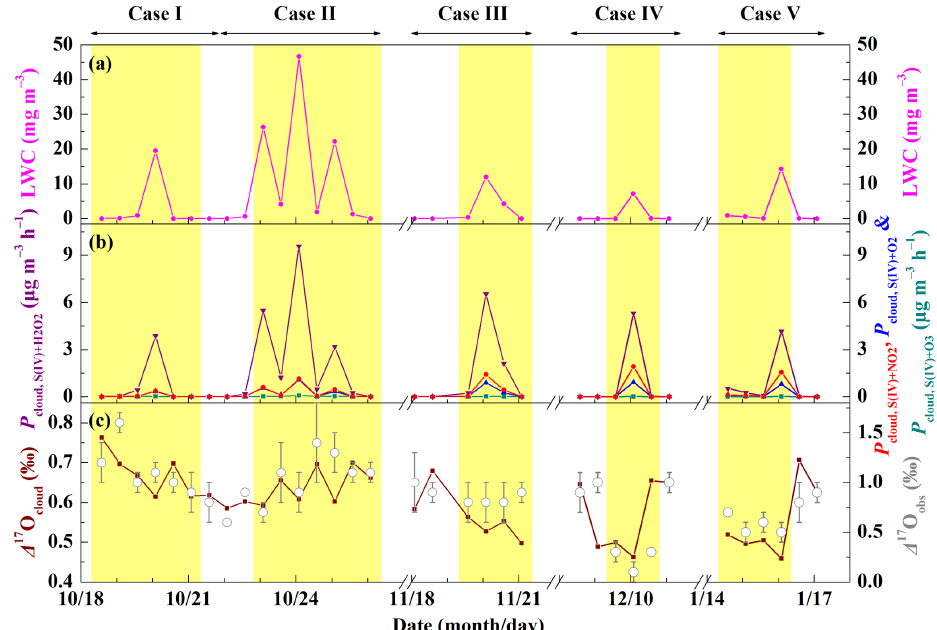
Figure 5. Temporal evolution of cloud liquid water content (LWC, a ), in-cloud sulfate production rate via S(IV) oxidation by H 2 O 2 , O 3 , NO 2 , and O 2 initiated by TMIs (denoted as P cloud , S ( IV ) + H b ) and estimated (cid:49) 17 O of sulfate produced in clouds ( (cid:49) 17 O cloud , c ). The light yellow shaded area indicates polluted days (PDs, PM 2 . 5 ≥ 75 µgm − 3 ). Data used here are 12-hourly averaged values, corresponding with filter